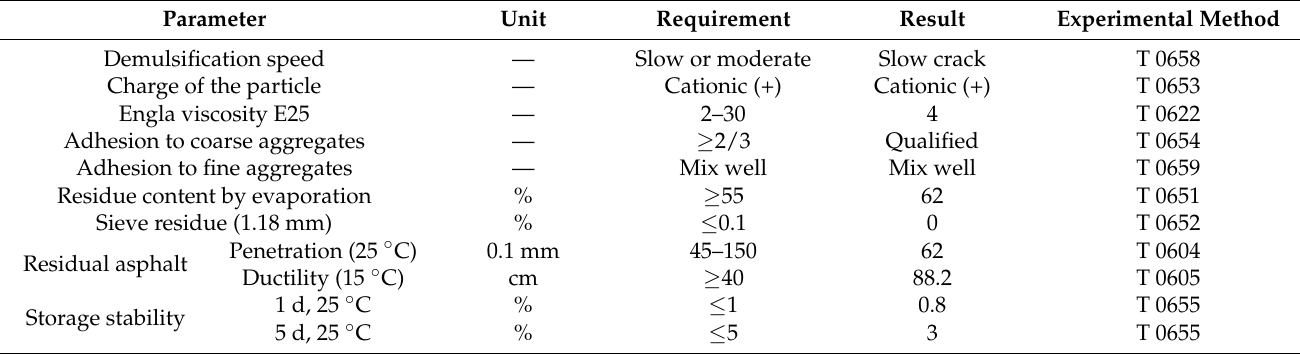
Table 5. Properties of emulsified asphalt.